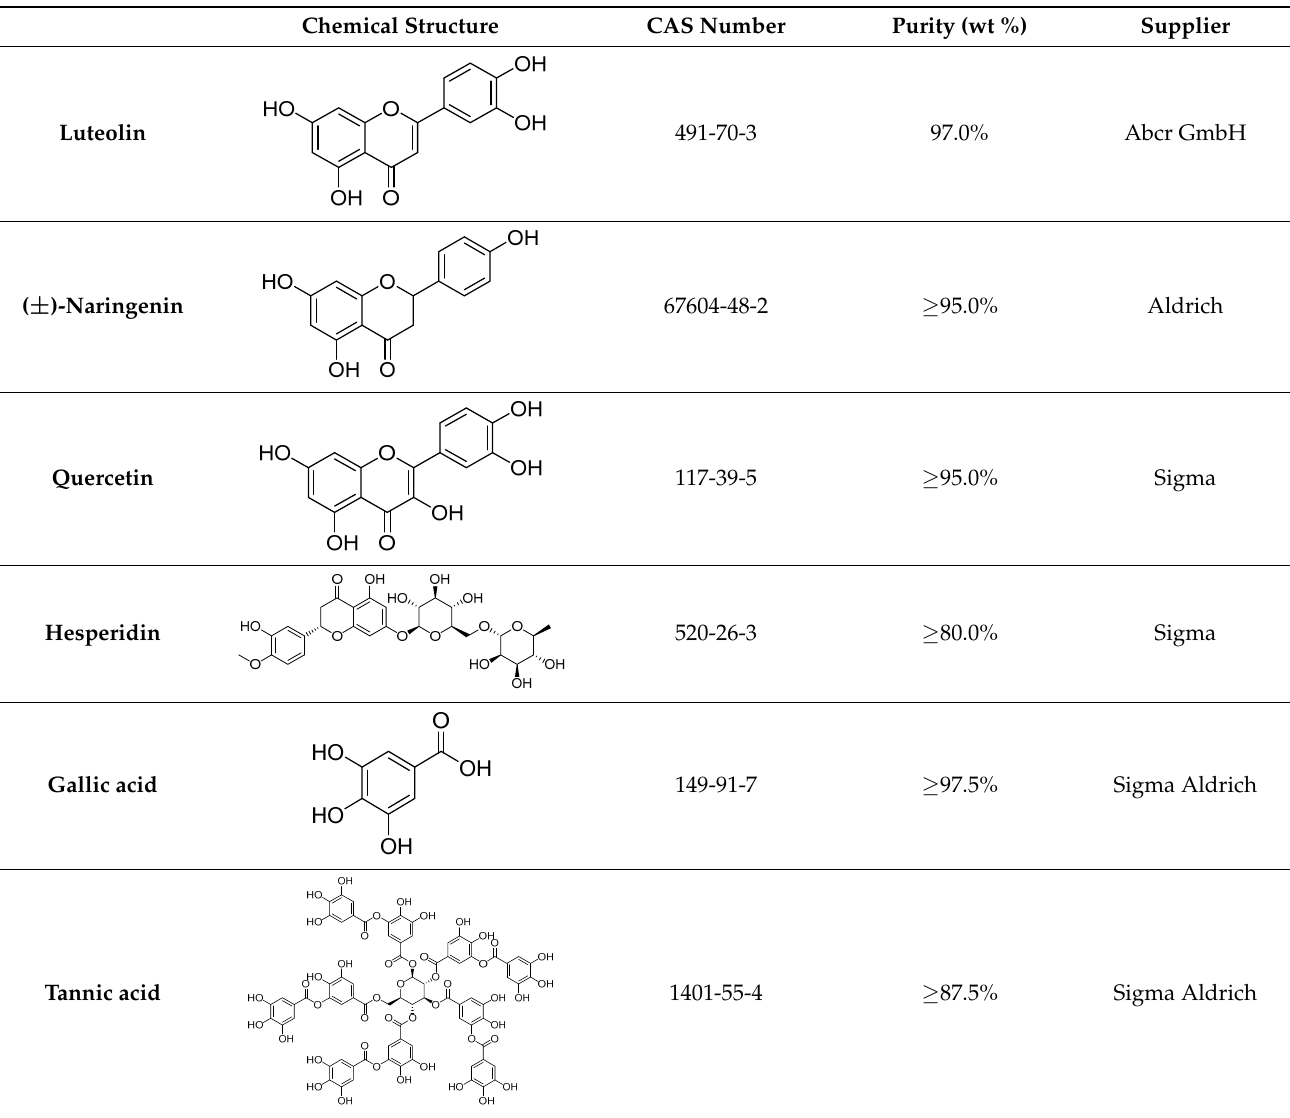
Table 1. Phenolic compounds studied in this work and their chemical structure, CAS number, purity and supplier.